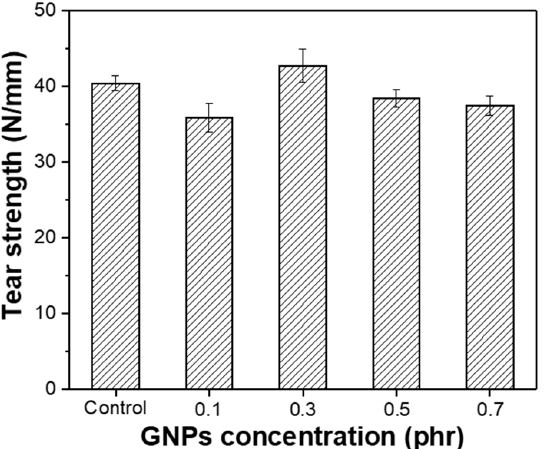
Figure 7. Tear strength of the control sample and the DOP-modified GNPs/NR rubber composites with various graphene contents.